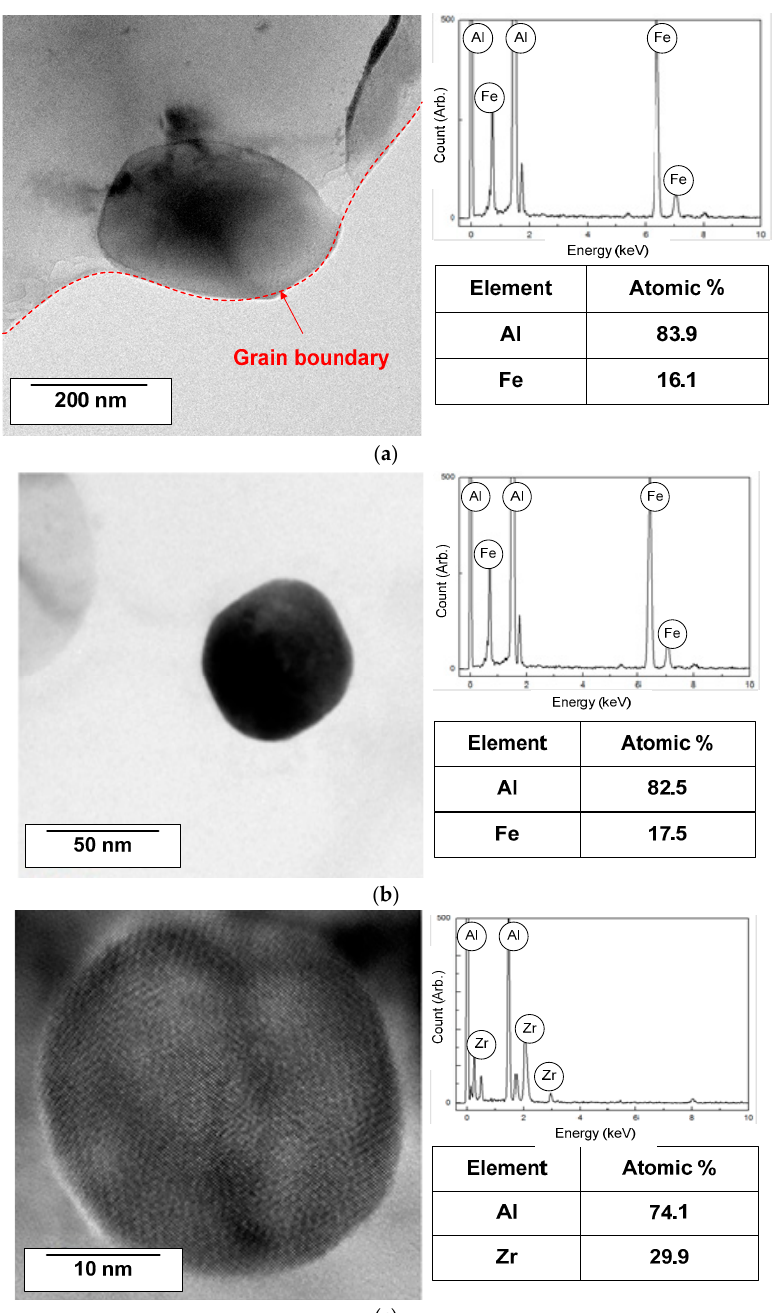
Figure 9. FE-TEM images and chemical composition of ( a ) Al-Fe IMP in A1070; ( b ) Al-Fe and ( c ) Al-Zr IMPs in U1070.